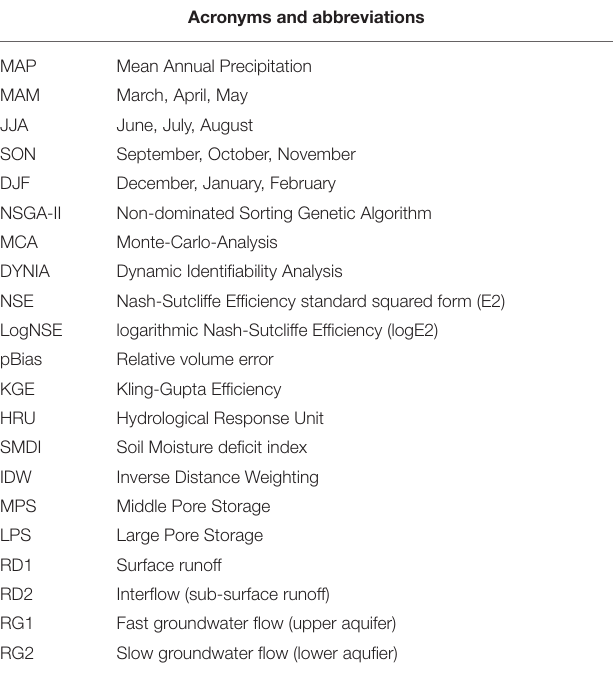
TABLE 2 | A list of the commonly used acronyms and abbreviations used for this study. Acronyms and